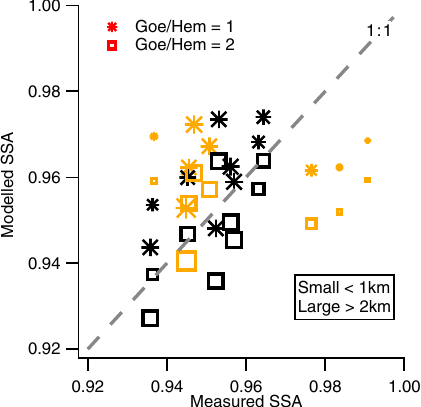
Figure 20. Modelled and measured SSAs for particle d < 2 .